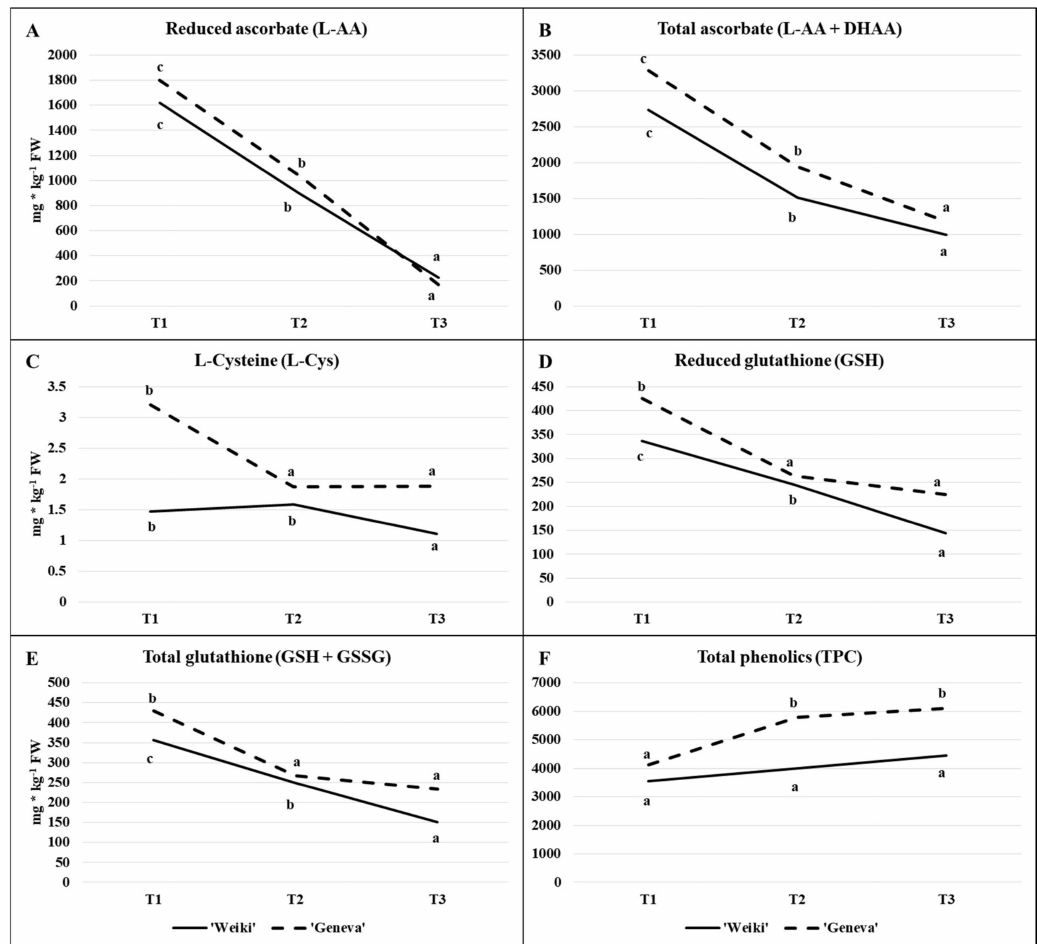
Figure 2. Concentration of bioactive compounds (mg kg − 1 FW) of: ( A ) reduced ascorbate, ( B ) total ascorbate, ( C ) L-cysteine, ( D ) reduced glutathione, ( E ) total glutathione, ( F ) total phenolics; depending on time of sampling in the leaves of two Actinidia arguta cultivars in 2015. Presented data are means for three soil N levels and three replications. Values marked with a different letter on each chart differ significantly at p ≤ 0.05 (Tukey HSD test). Cultivars were analysed separately; T1— (28.05.15) the stage of fully developed leaves, T2—(16.07.15) the peak of the most intensive fruit growth and T3—(27.08.15) the beginning of fruit physiological maturity.